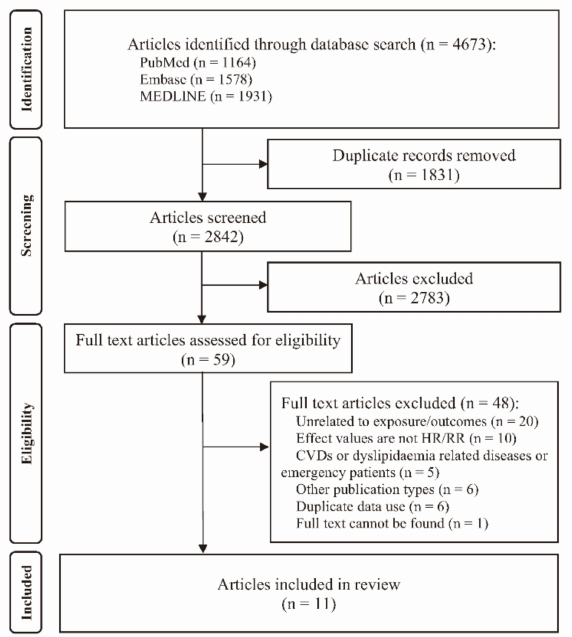
Figure 1. Study screening